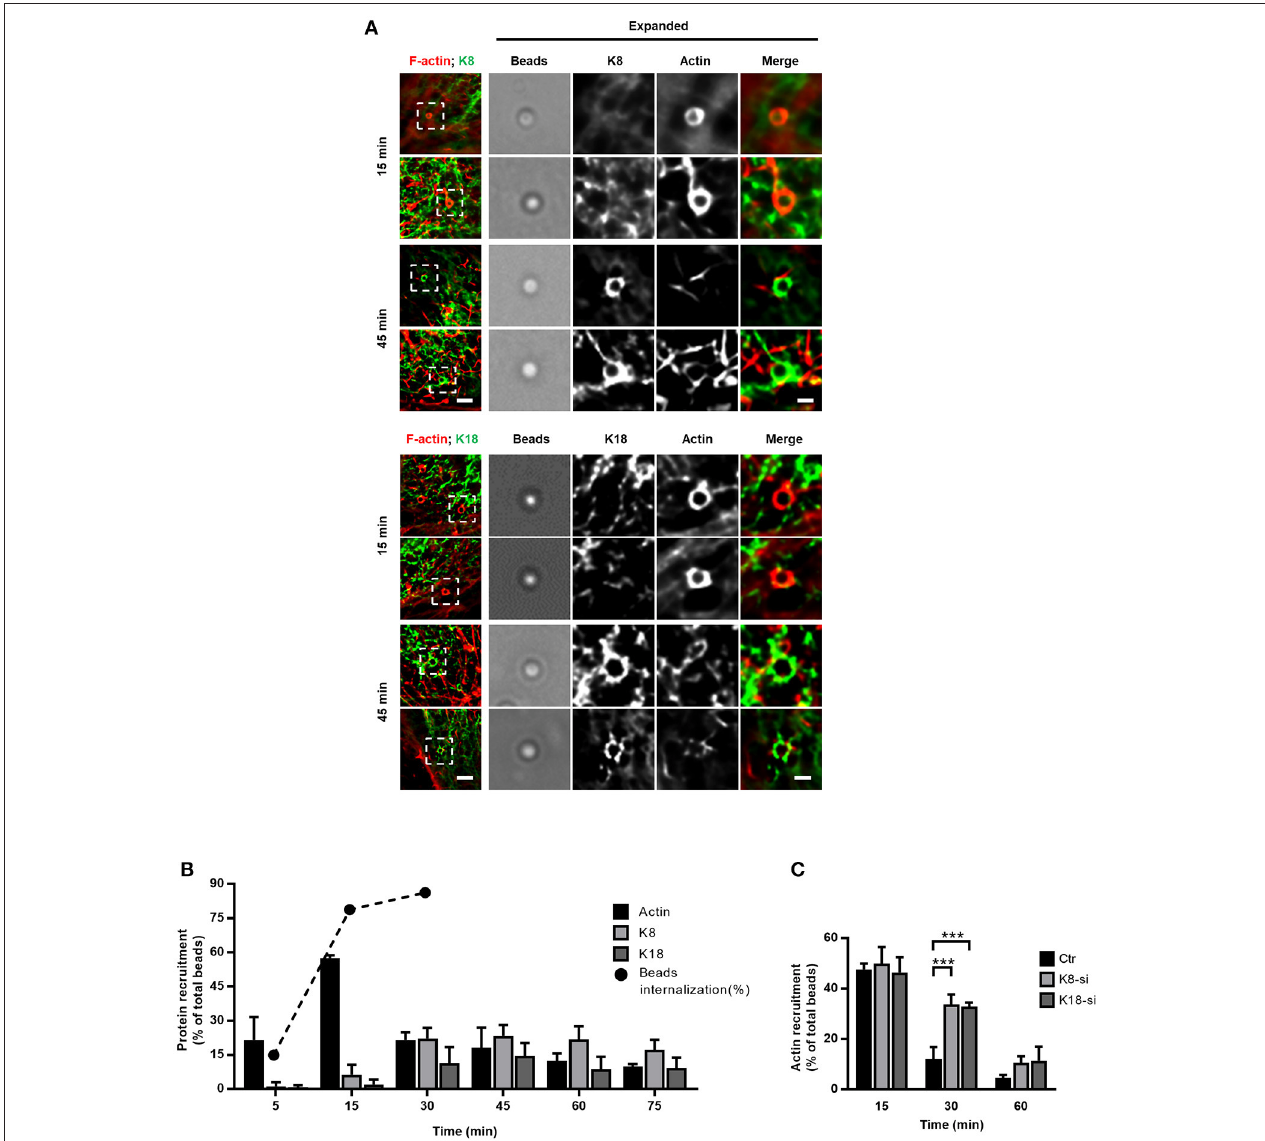
FIGURE 3 | K8 and K18 assist actin depolymerization during later stages of internalization. (A,B) Kinetic analysis of actin, K8 and K18 recruitments during internalization of InlB-coated latex beads. (A) Stack projections of widefield microscopy images of HeLa cells incubated with InlB-coated latex beads for different periods of time, fixed, immunostained for K8 or K18 (green) and labeled for F-actin with TRITC-phalloidin (red). Scale bar, 3 µ m. Insets show high-magnification images. Scale bar, 1 µ m. (B) Quantification of beads positive for K8, K18, or actin recruitment. Results are expressed as the percentage of particles associated with either protein in relation to the total number of particles associated to cells. The total number of beads was determined in brightfield. Values are the mean ± S.E. of at least three independent experiments. For determination of beads internalization, extracellular beads were stained with anti-InlB before cell permeabilization and total beads number quantified in brightfield. Values are shown in percentage and are representative of two independent experiments. (C) Quantification of InlB-coated latex beads associated to polymerized actin in HeLa cells transfected with control (Ctr) or specific siRNA targeting K8 (K8-si) or K18 (K18-si). Cells were incubated with InlB-coated latex beads for 15, 30, and 60min, fixed and stained for F-actin. Beads displaying actin recruitment were considered recruitment-positive. The total number of beads associated to cells was determined in brightfield. Values represent the mean ± S.E. of at least three independent experiments. Statistically significant differences are indicated: *** p <